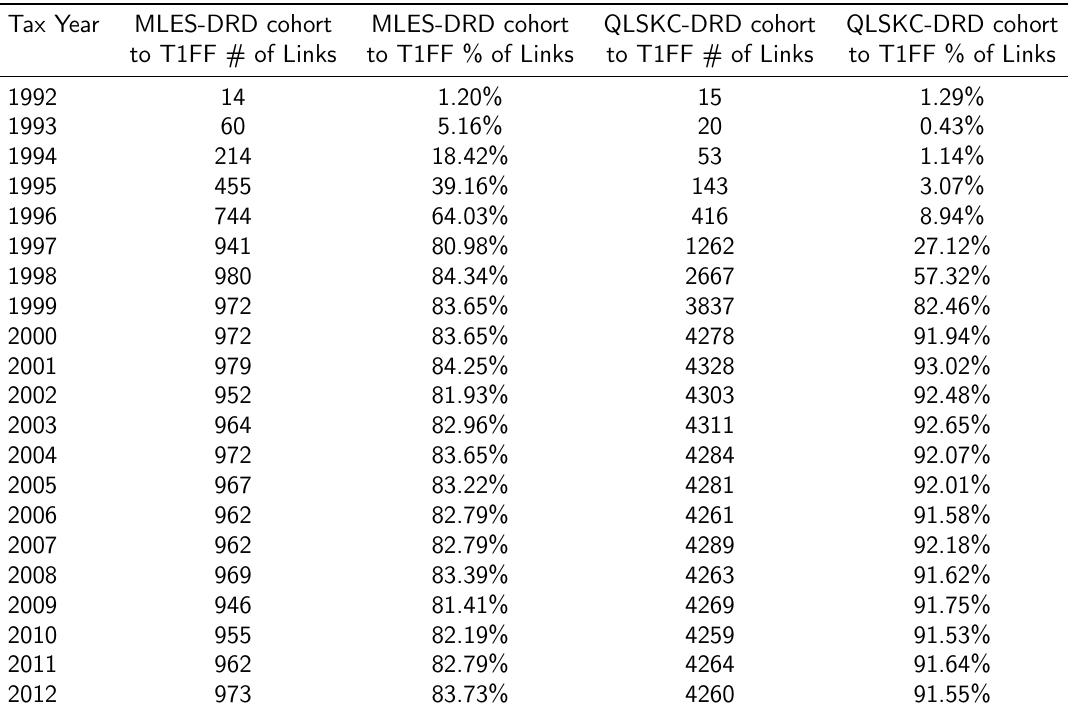
Table 4: Linkage rate of the Quebec cohorts to the